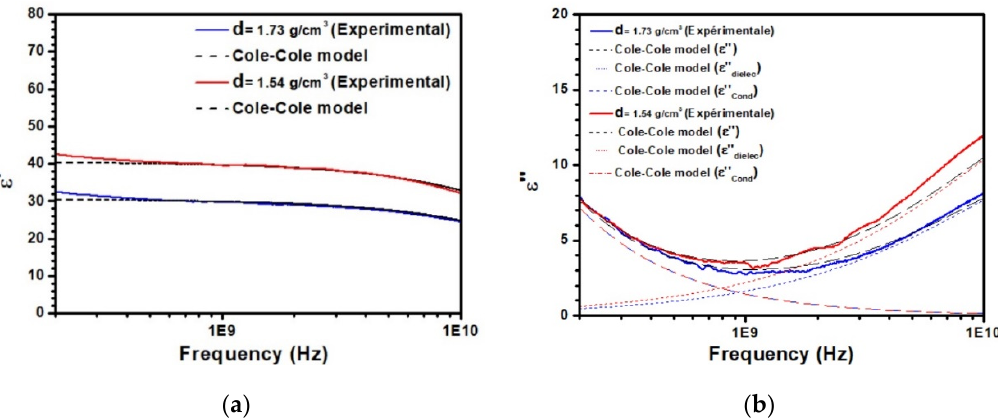
Figure 2. Fitting of the experimental data by the Cole–Cole model for ( a ) the real part and ( b ) the imaginary part of the relative dielectric permittivity. The contributions of the two terms of Equation (2) are displayed in b. Table 1. Values of the parameters used in the Cole–Cole model detailed in Equations (1) and (2). d(g/cm 3 ) 𝜺′ 𝒔 𝜺′ (cid:2998)